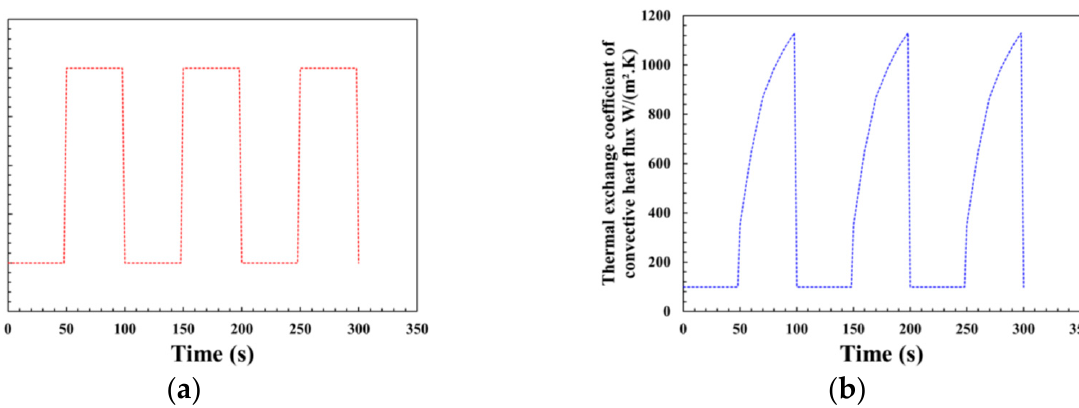
Figure A8. Z-set axisymmetric mesh of the TMF tubular specimen with the top edge: end of the jaw, and the bottom edge: as the middle of the specimen. References 1.